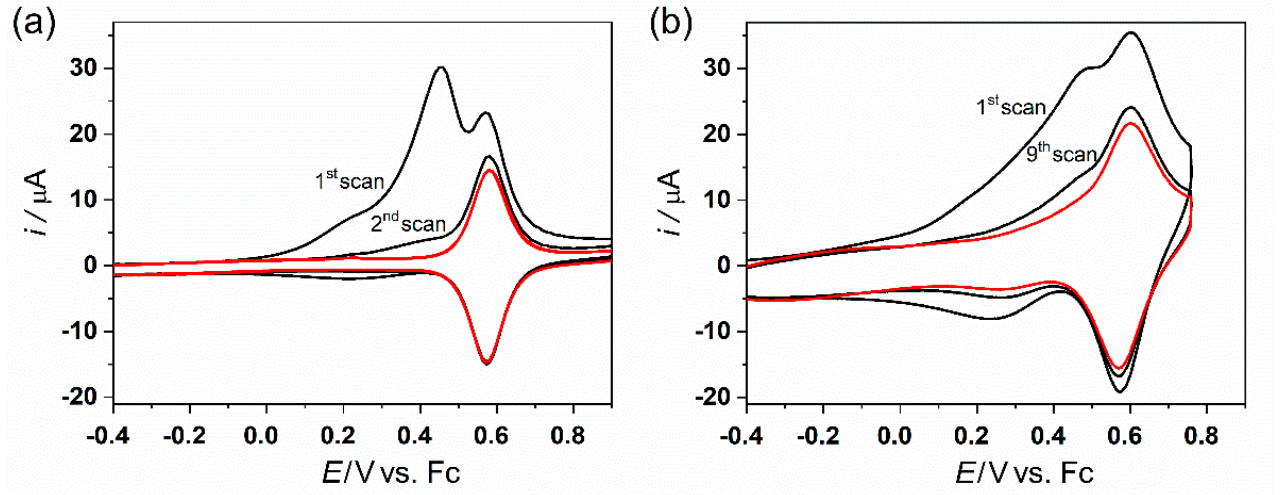
Figure 2. Cyclic voltammogram for Os-tripod SAM on: ( a ) Au bead polycrystalline electrode in 0.5 M TBAPF 6 in acetonitrile, electrode area 0.267 cm 2 ; ( b ) Au(111) on mica electrode in 0.1 M TBAPF 6 in acetonitrile, immersed geom. area approx. 0.55 cm 2 . Scan rate was 0.1 V s − 1 . Red color indicates final voltammogram.